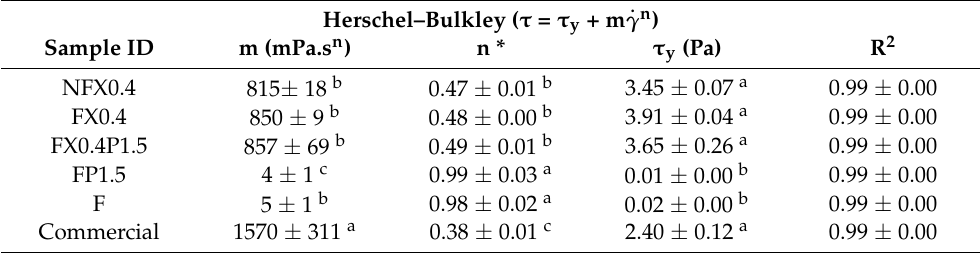
Table 7. Herschel–Bulkley model parameters for samples. Data are presented as mean values of triplicates ± standard deviation. The third sample of FP1.5 was excluded. Values for each column not connected by the same letters are significantly